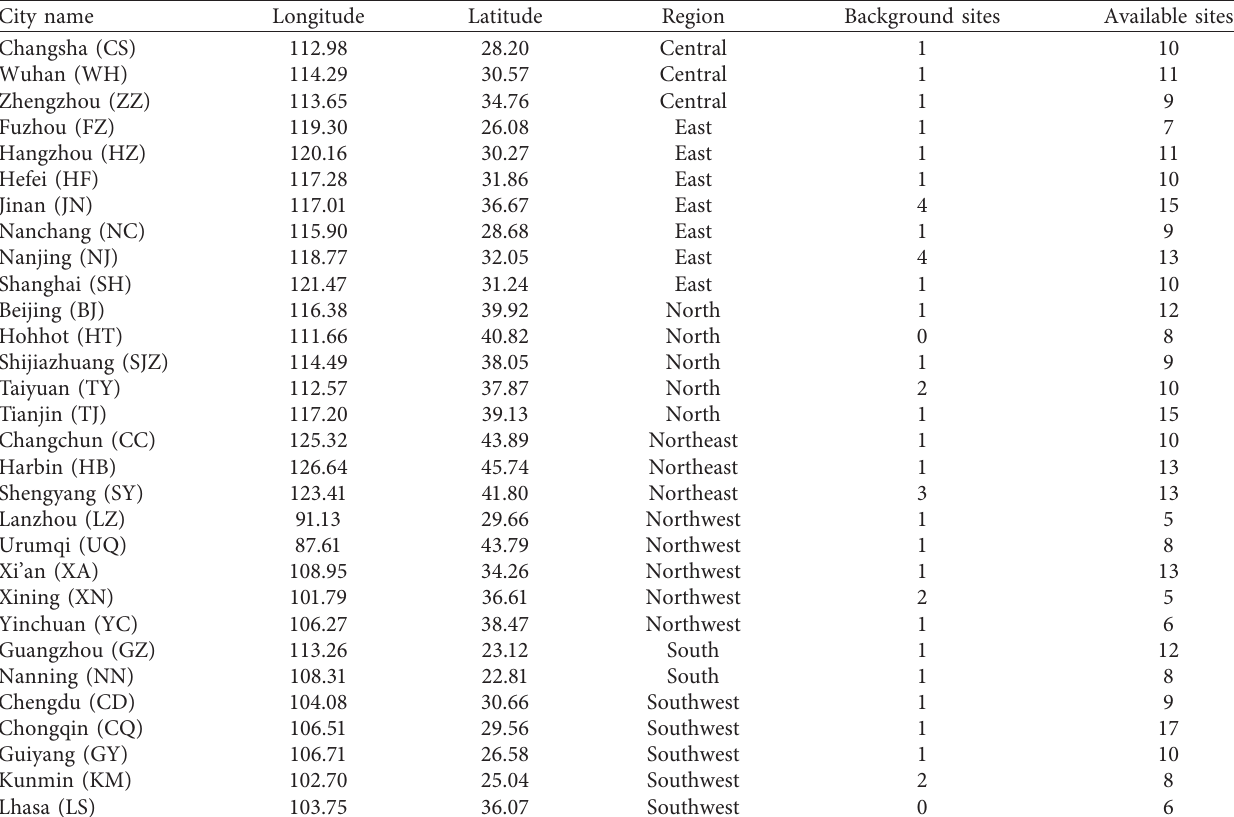
Table 1: Longitude-latitude, regional category, number of background sites, and available monitoring sites of 30 provincial capitals in